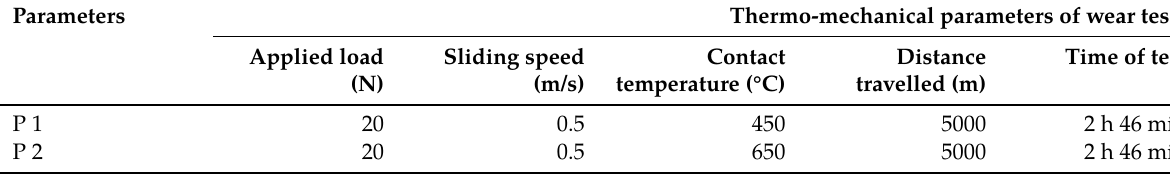
Table 3: Thermo-mechanical parameters of wear tests applied to each grade. Parameters